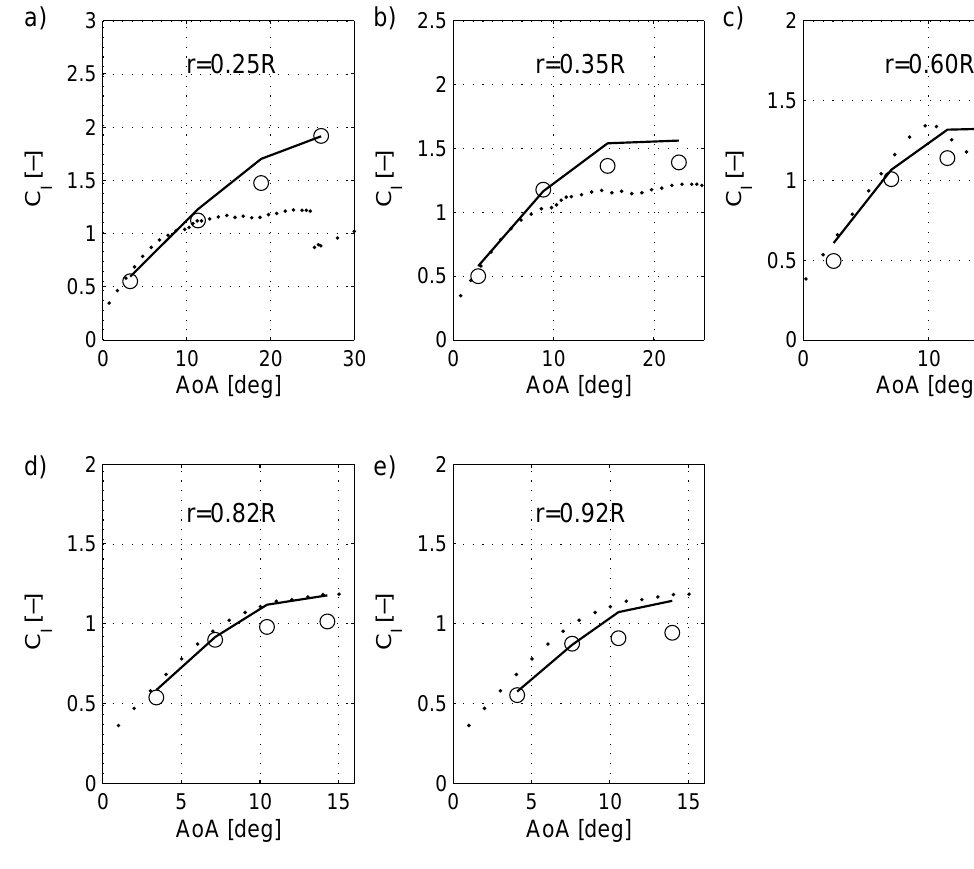
Figure 1. Comparison of C characteristics at five different spanwise positions l corresponding to ( a ) 0.25R, ( b ) 0.35R, ( c ) 0.60R, ( d ) 0.82R and ( e ) 0.92R. The dotted lines represent 2D experimental results; the circles indicate 3D experimental results and the full lines show 3D numerical